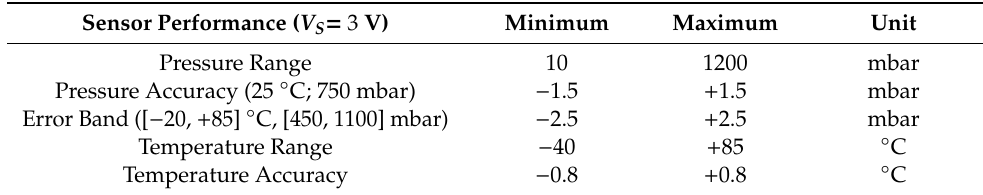
Table 1. MS5611-01BA03 technical data.